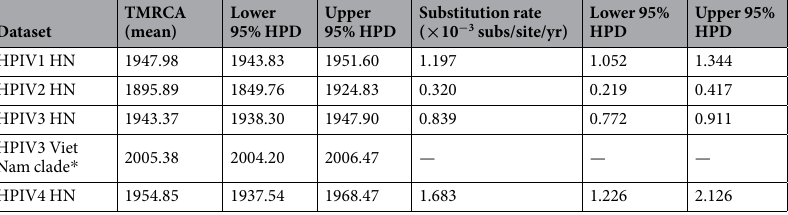
Table 2. TMRCAs and nucleotide substitution rates with 95% highest posterior density (HPD) intervals reported for each dataset. An asterisk denotes the monophyletic clade of HPIV3 viruses from Viet Nam indicated in Fig.